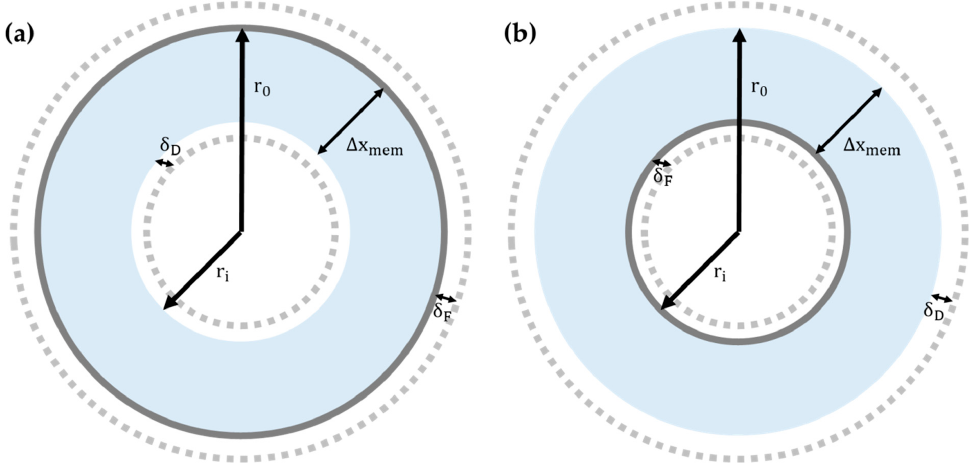
Figure 6. The cross-sectional diagrams of a single hollow fiber of which a selective layer is positioned at ( a ) the outer skin, and ( b ) the lumen side.